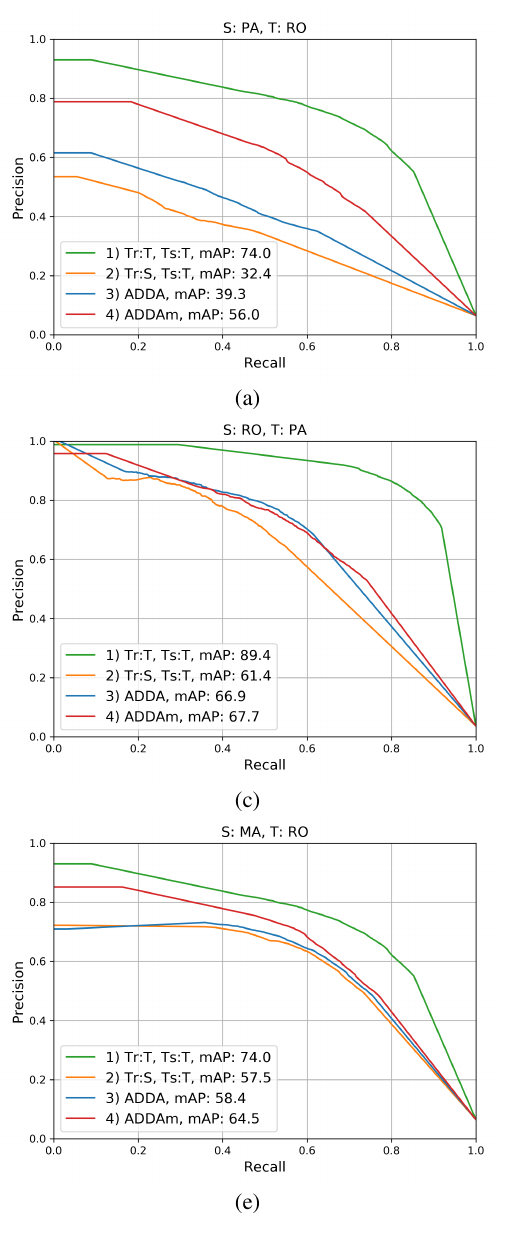
Figure 4. Precision vs. Recall curves and Mean Average Precision (mAP) in [%] for the six scenarios, considering the four variants described in the main text. These metrics are related to the class deforestation . S / T: Source / Target